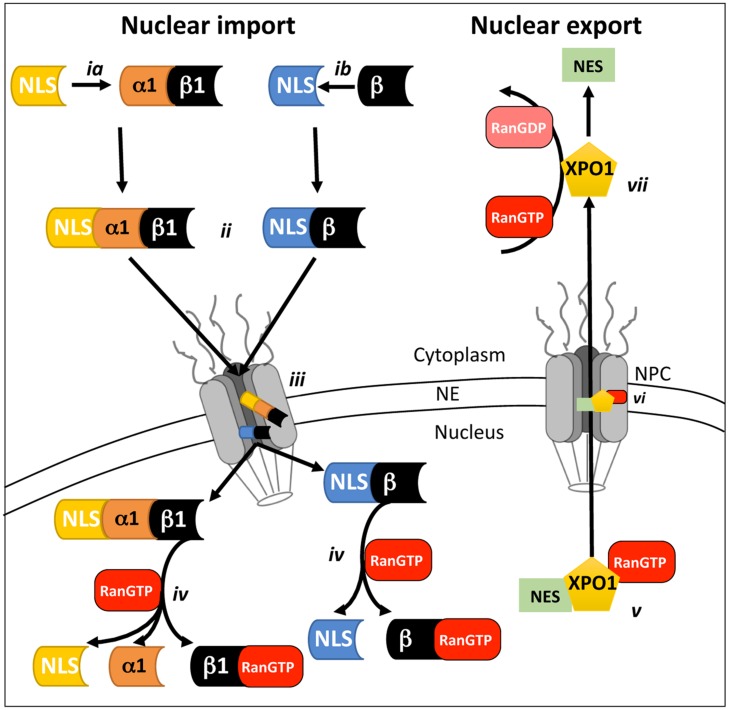
Schematic representation of mammalian cell nucleocytoplasmic transport. Nuclear transport across the NE requires the recognition and binding of NLS-containing cargo proteins by either the IMPα/β1 heterodimer (ia) or IMPβ homologues alone (ib) on the cytoplasmic side of the NPC. Once bound (ii), the transport complex is believed to dock to the cytoplasmic side of the NPC and then move through the NPC (iii) via a series of transient interactions between IMPβ and the nups that comprise the NPC. Once within the nucleus, binding of RanGTP (iv) to Impβ causes dissociation of the transport complexes and release of the cargo to perform its nuclear function. Nuclear export (v) requires the recognition of a nuclear export sequence (NES)-containing cargoes by an XPO such as XPO1 in complex with RanGTP. The trimeric RanGTP/XPO1/cargo complex passes through the NPC via a series of transient interactions (vi) with nups within the NPC. Once within the cytoplasm, hydrolysis of RanGTP to RanGDP (vii) results in dissociation of the XPO1/cargo complex.